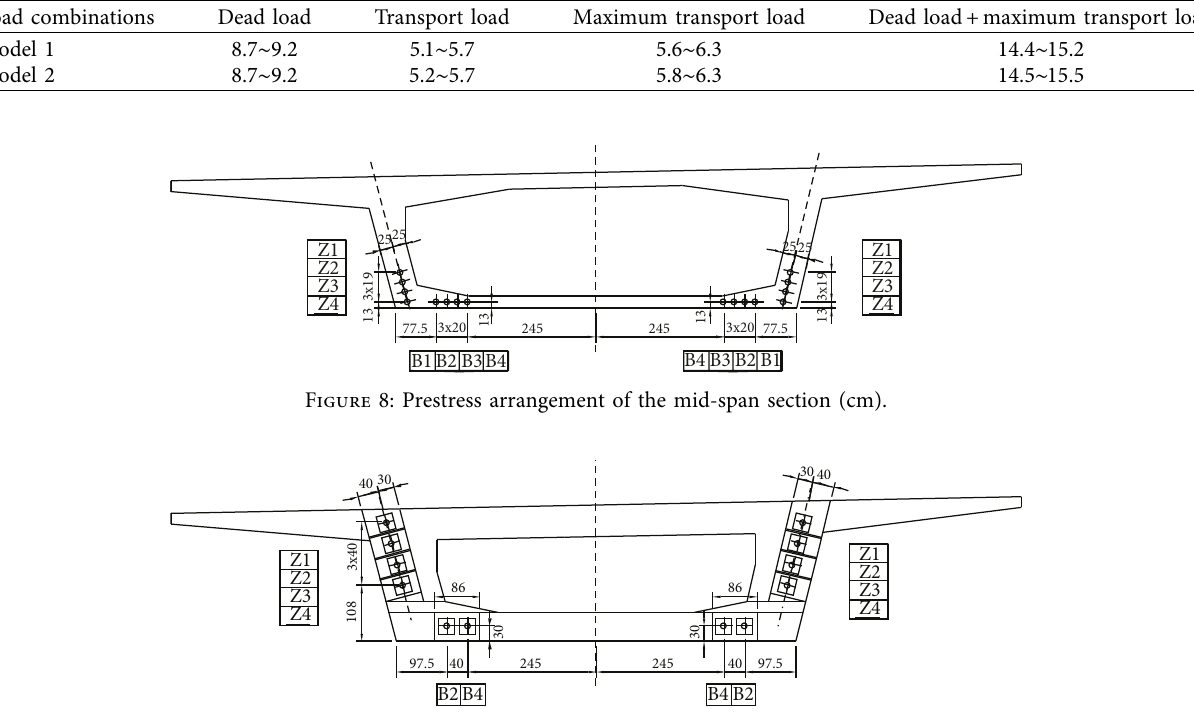
Figure 9: Prestress arrangement of the end section (cm). Table 3: The design parameters of posttensioning